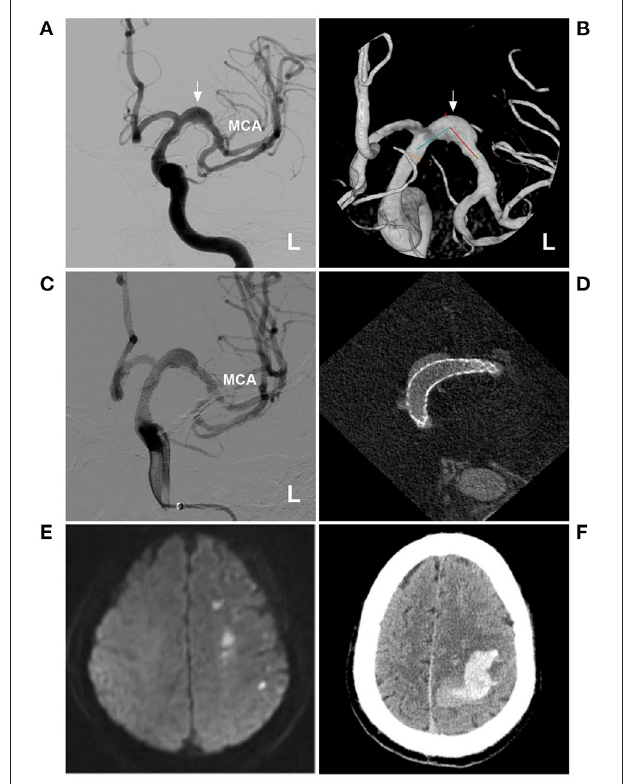
FIGURE 3 | FD deployment for a fusiform aneurysm of the proximal MCA. (A,B) DSA (A) and three-dimensional DSA (B) showed a fusiform aneurysm of the proximal MCA (arrows). (C,D) DSA (C) and maximum-intensity projection image (D) showed FD deployment. (E) MRI showed acute infarction in the frontal and parietal lobes. (F) CT showed the delayed intracerebral hemorrhage. CT, computed tomography; DSA, digital subtraction angiography; FD, flow diversion; MCA, middle cerebral artery; L, left; MRI, magnetic resonance